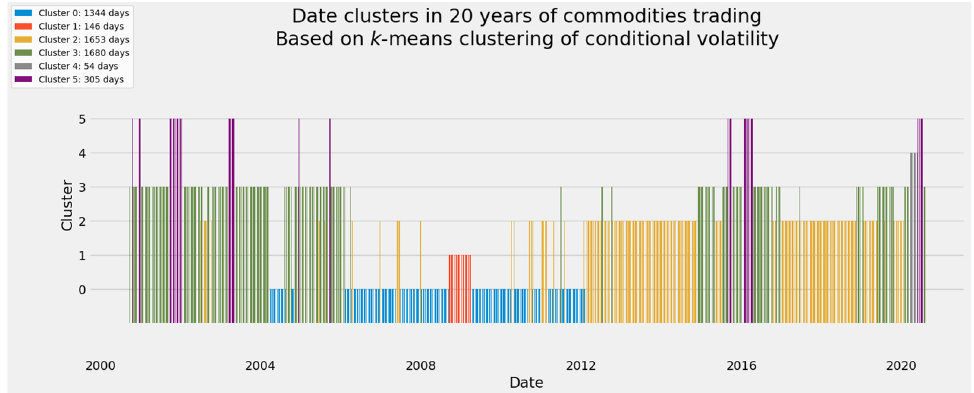
Figure 16. k -means clustering of commodity markets—An ordered timeline.